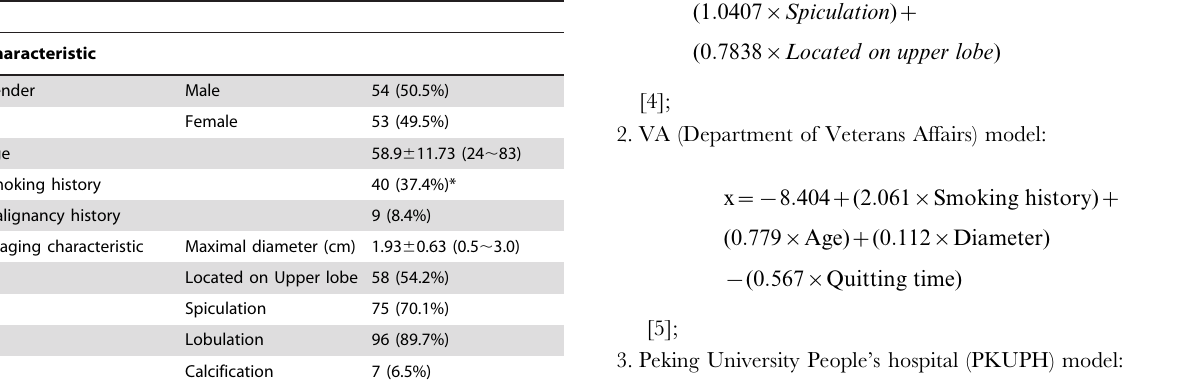
Table 1. Patient